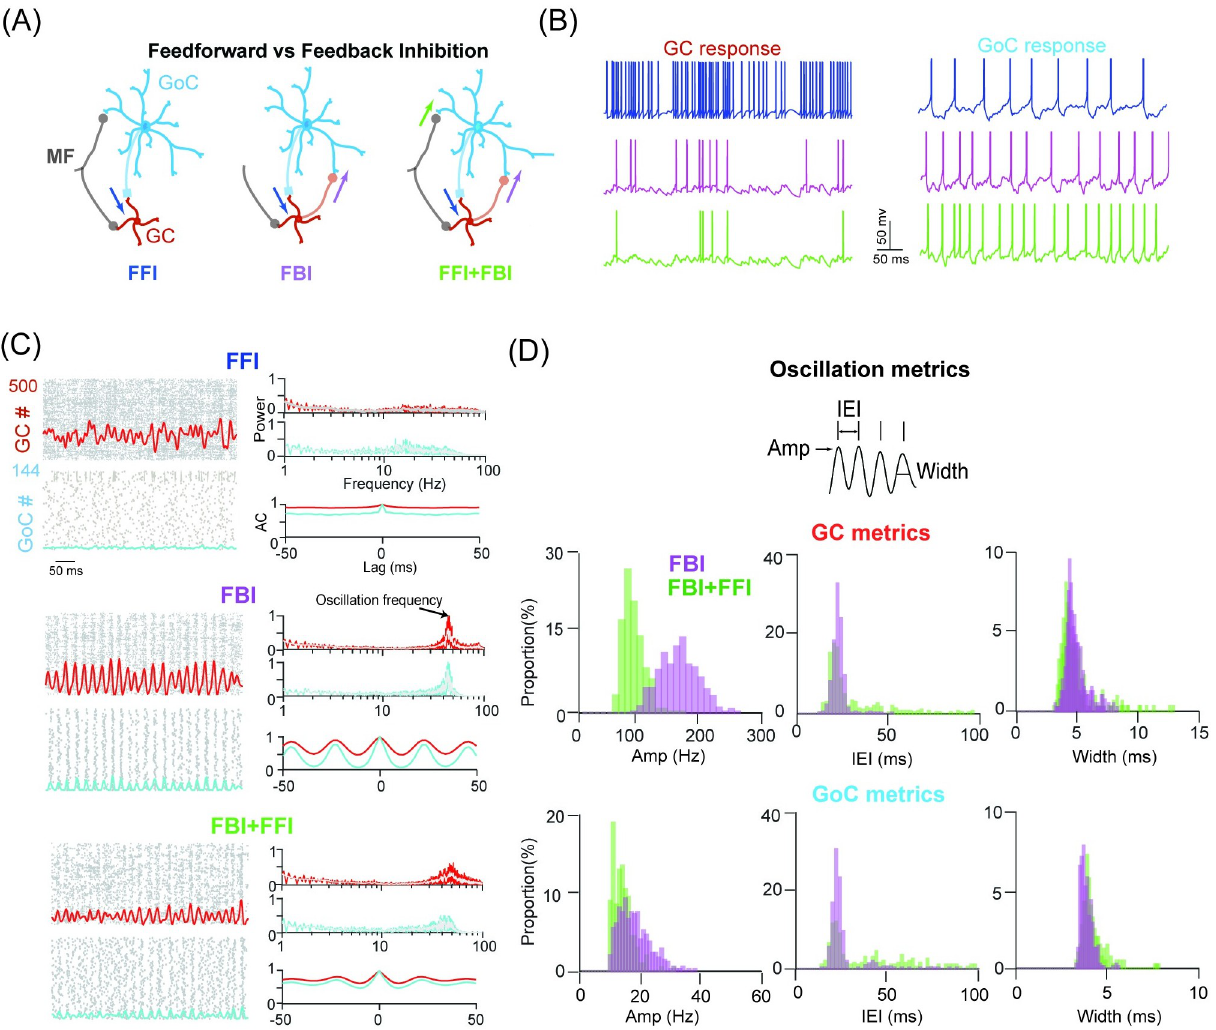
Fig 1. Network synchronous oscillation induced by feedback inhibition. (A) Schematic illustration of three scenarios of network connections between GCs and GoCs with feedforward inhibition (FFI, left), feedback inhibition (FBI, middle) and both inhibition loops (FFI+FBI, right). Mossy fiber (MF). Granule cell (GC). Golgi cell (GoC). (B) Example membrane potential traces of a single GC in three scenarios, evoked by 50 Hz Poisson MF inputs. (C) Spike raster and population firing rate of 500 GCs and 144 GoCs (left), and the corresponding power spectrum and autocorrelation (AC) of population firing rate (right) in three network scenarios. Note the network oscillation is present only with the FBI included. The peak of the power spectrum indicates the oscillation frequency of the network. (D) Network oscillation metrics characterized by the amplitude (Amp), inter-event interval (IEI) and width. Histograms of three metrics for GC (top) and GoC